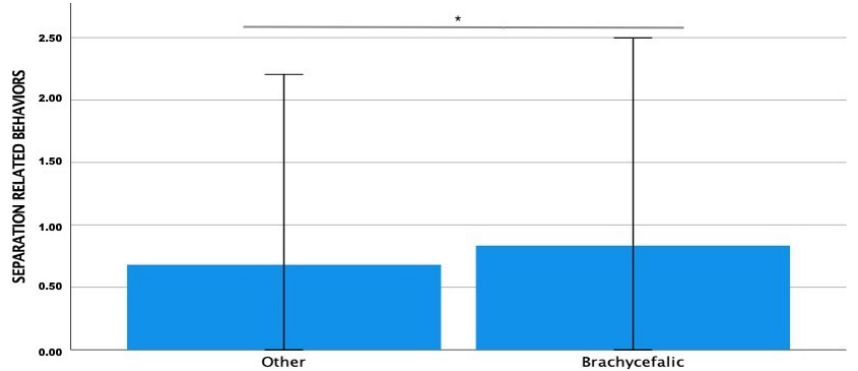
Figure 6. Comparison of Fe-BARQ mean scores for separation-related behaviours between brachy- cephalic and non-brachycephalic breeds. * p = 0.037.